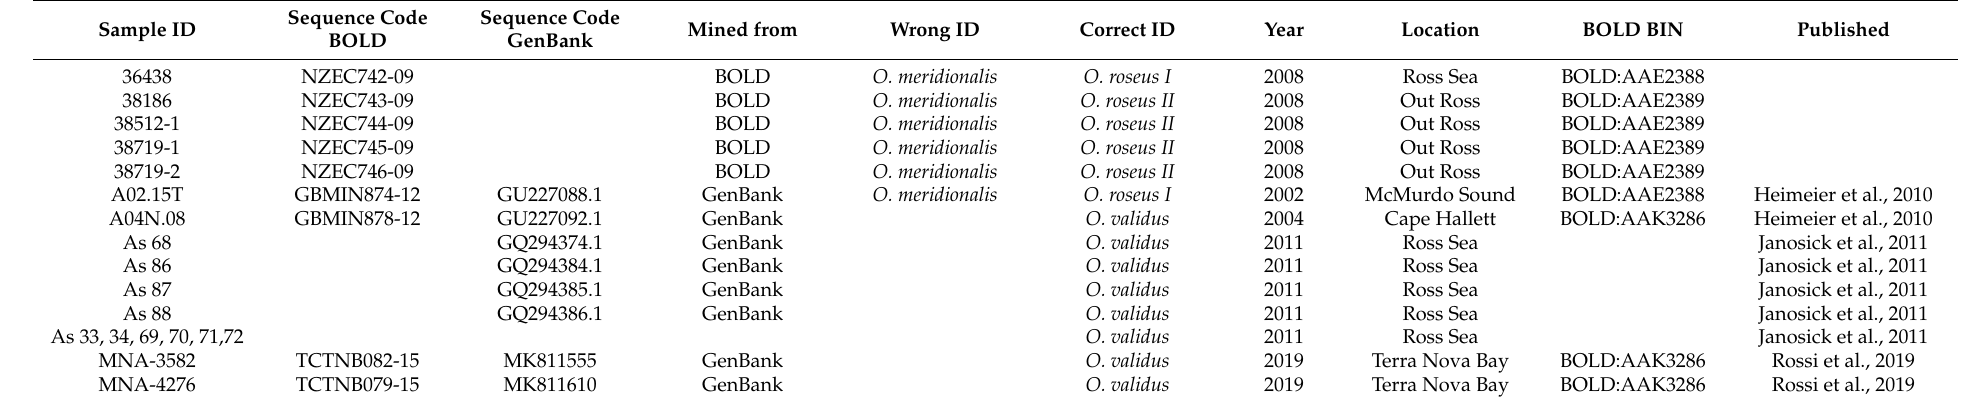
Table 4. A list of all the Odontaster sequences from the Ross Sea area available from online databases. Samples ID As 33, 34, 69, 70, 71, and 72 from Janosik et al. [35] are listed in the paper but sequences were not available in